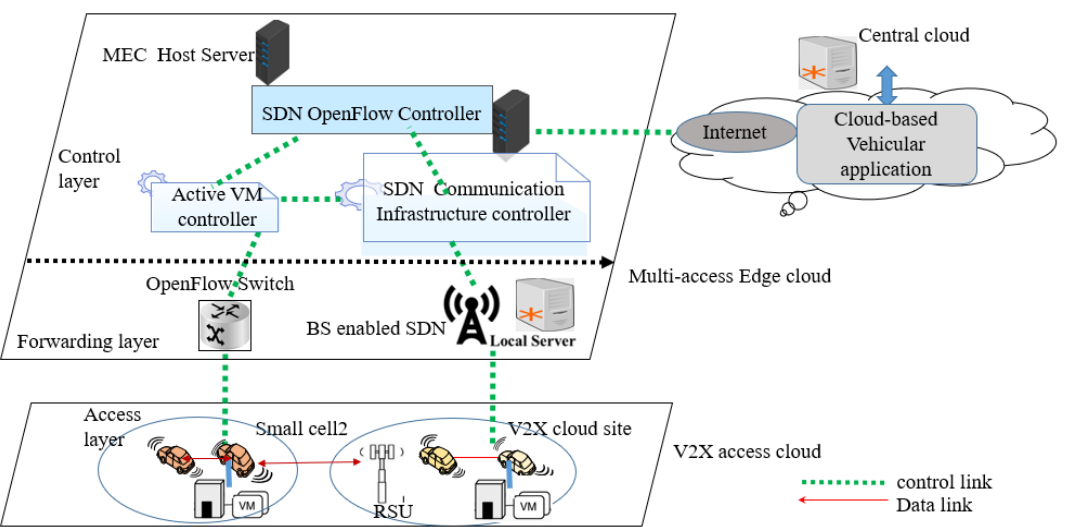
Figure 5. Software-defined vehicular cloud network